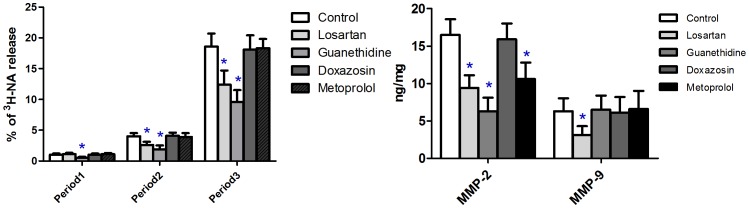
In vitro experiments on SD rat aorta rings investigating AngIIstimulated NA release and MMP-2, 9 expression after chemical sympathectomy or receptor antagonism.Data shown are means ±SD. *P<0.01 related to control.